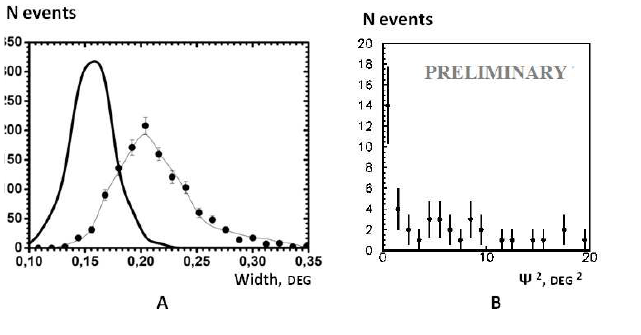
Figure 3. Example of a hadron-like joint event. Image parameters: Size = 18500 p.e., Width = 0.4 ◦ , Figure 4. A:Image Width distribution for joint events. Solid circles - experiment. Thin solid line - MC Alfa = 11 ◦ . (cosmic rays), thick solid line - MC (gamma quanta). B: Ψ 2 distribution for hybrid events after cuts (preliminary